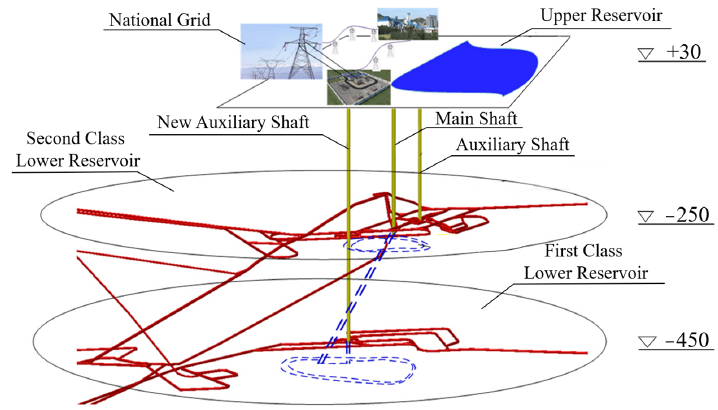
Figure 6. Shitai Mine pumped storage project